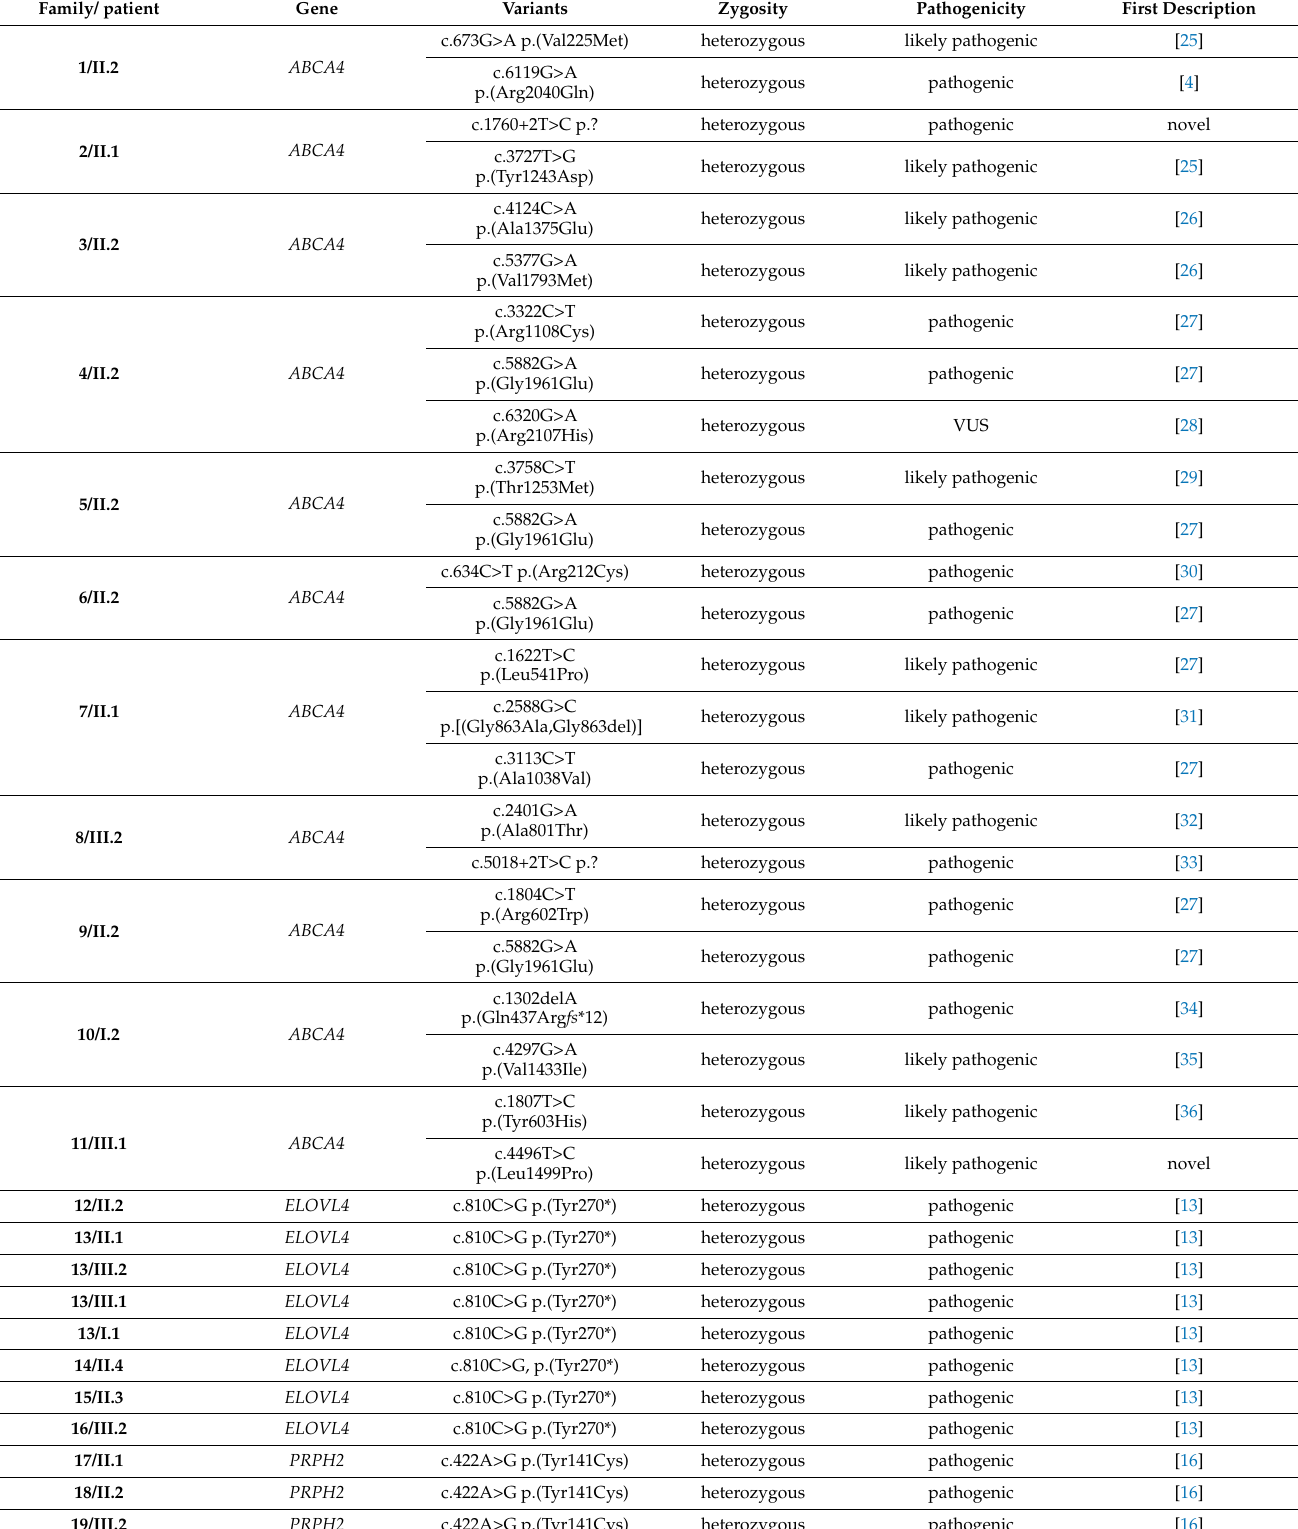
Table 1. Patients’ genotypes. The reference transcripts for variant numbering using A in ATG as number 1 are NM_000350.3 for ABCA4 , NM_022726.3 for ELOVL4, and NM_000322.5 for PRPH2 . Pathogenicity is according to the criteria of